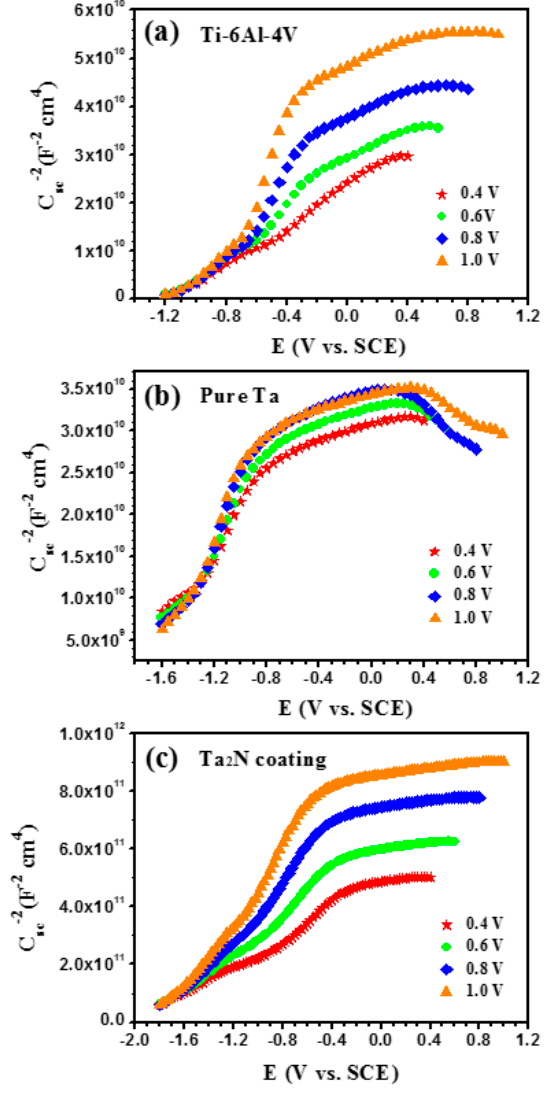
Figure 13. Mott-Schottky plots of the passive films formed at different potentials (0.4, 0.6, 0.8, 1.0 V) on ( a ) uncoated Ti-6Al-4V; ( b ) commercially pure Ta and ( c ) the Ta 2 N coating in Ringer’s physiological solution.